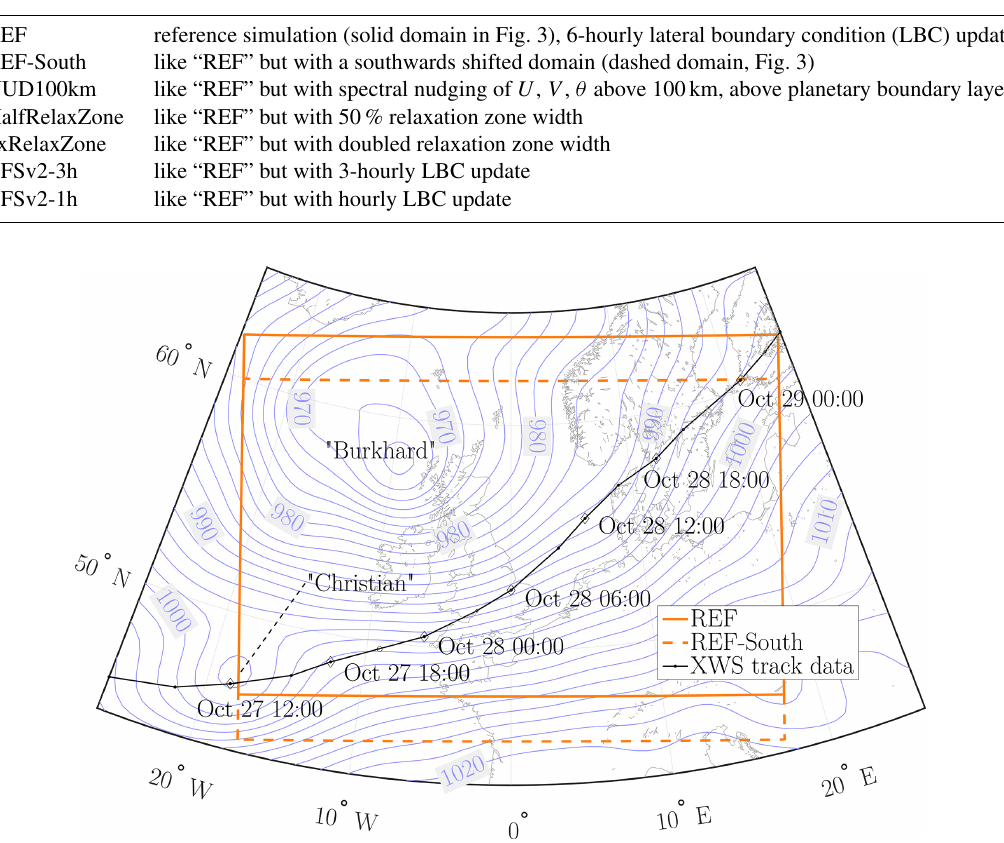
Figure 3. Depiction of the WRF domains “REF” and “REF-South” used in the analysis in Imberger et al. (2020) together with the contour of sea level pressure of CFSv2 at 27 October 2013, 12:00UTC showing the location of storm Christian and low Burkhard . The storm track from the Extreme Wind Storms Catalogue is included as well. Reprinted from Imberger et al. (2020), copyright 2020 Royal Meteorological